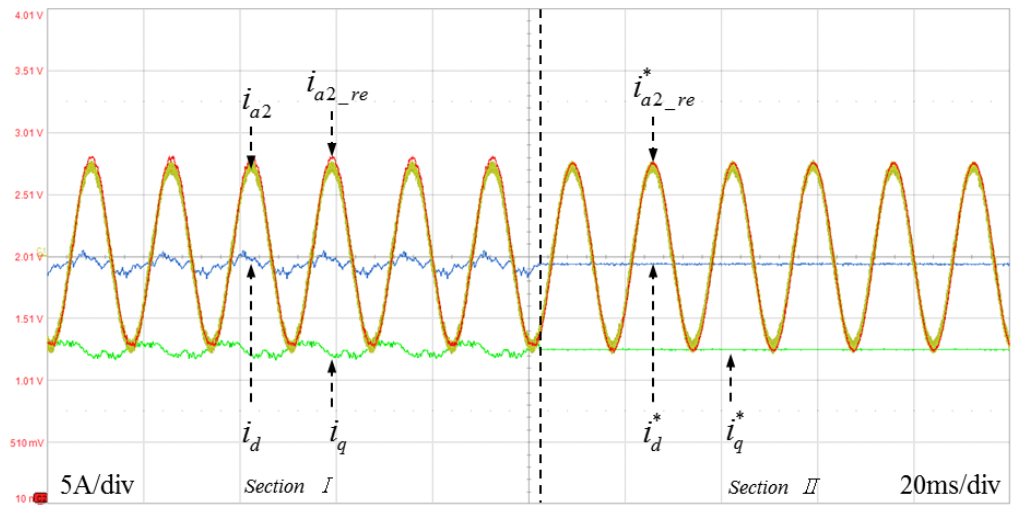
Figure 9. The actual current and reconstructed currents with the synchronous current of the inverter 2.